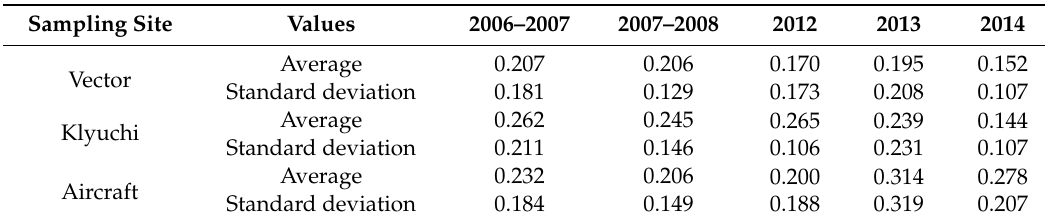
Table 3. Annual average values and standard deviations from them of the integral index of culturable microorganisms ’resistance to antibiotics bacteria and yeast in an atmospheric aerosol in the south of Western